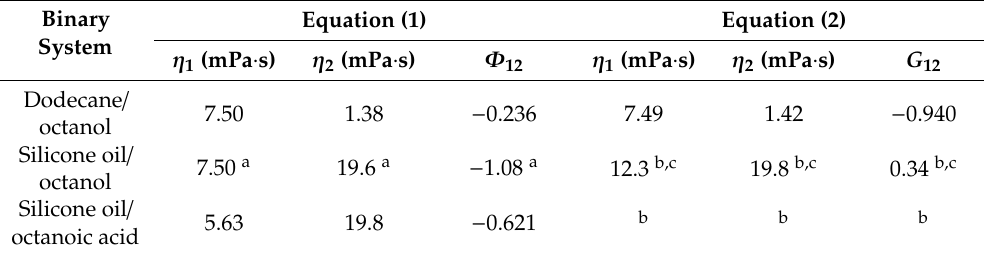
Table 2. Grunberg–Nissan analyses of the viscosity of the binary liquid mixtures (24.0 ± 0.5 ◦ C). Binary Equation (1) Equation (2) System η · s) η · s) Φ 1 (mPa 2 (mPa 12 G 12 Dodecane / 7.50 1.38 octanol octanol octanoic